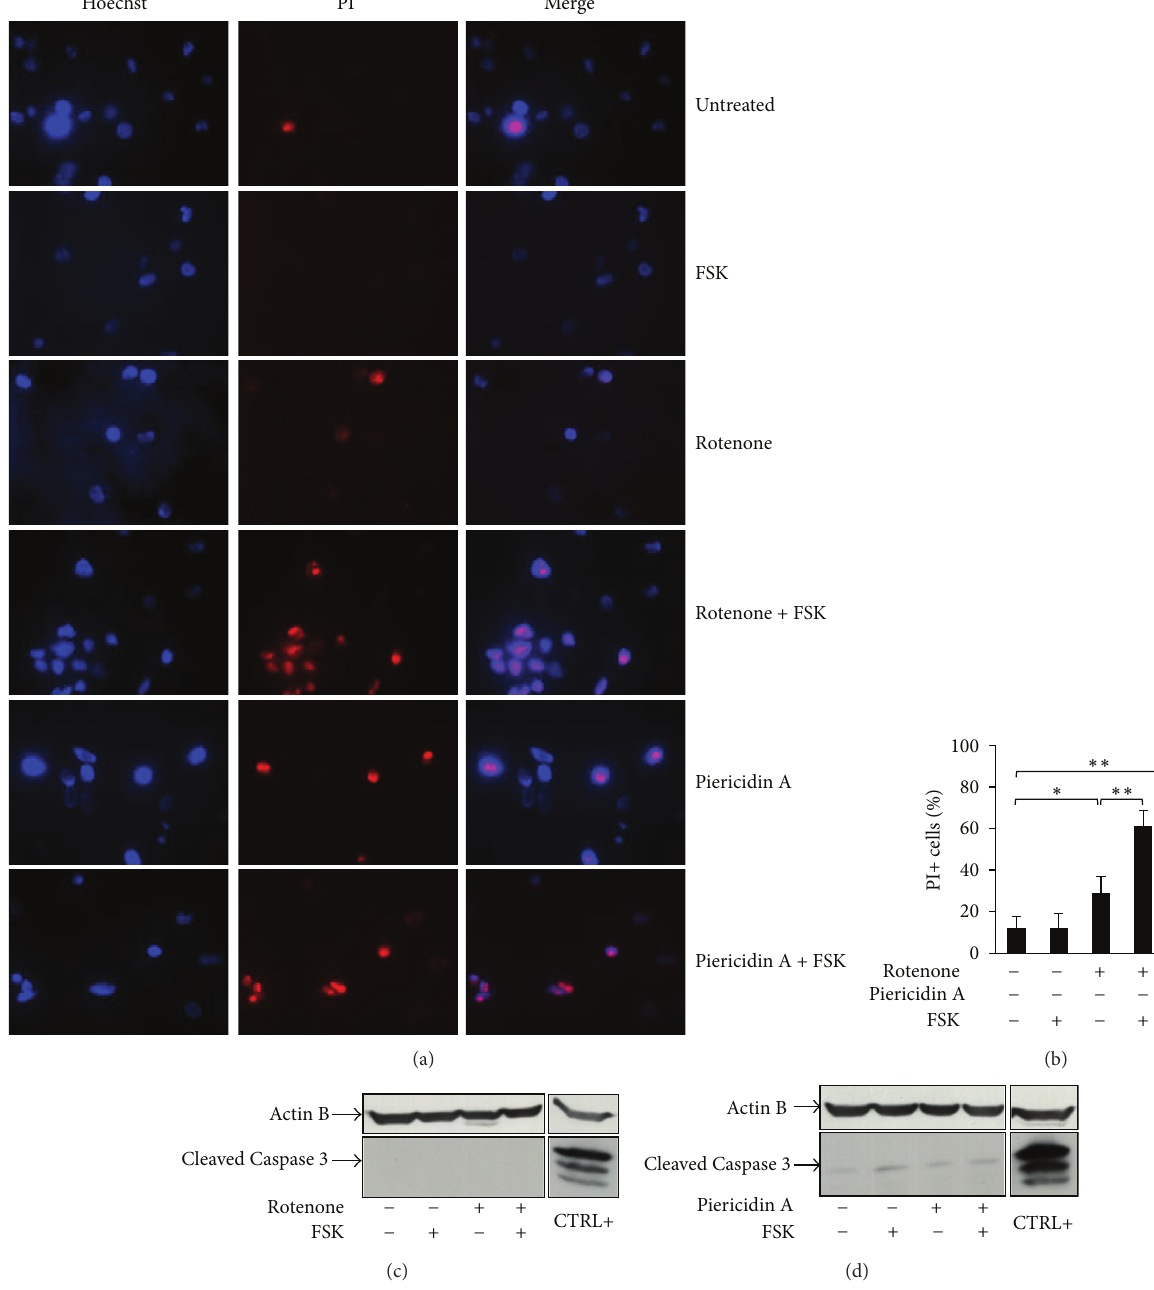
Figure 5: The combined treatment with Complex I inhibitors and FSK induces necrosis of MDA-MB-231 cells. Analysis of cell death was performed for MDA-MB-231 cells grown in low glucose and treated with 3nM rotenone and 5 nM piericidin A alone or in combination with FSK. (a)-(b) Cells were stained with Hoechst and PI (a). As indication of necrosis cells that incorporated PI were counted and shown as percentage of the total cells (stained with Hoechst) considering at least 100 cells per sample (b). Data represent the average of at least three independent experiments ( ± s.d.); ∗ 𝑃 < 0.05 , ∗∗ 𝑃 < 0.01 (Student’s 𝑡 -test). (c)-(d) As indication of apoptosis the expression of the cleaved Caspase 3 was analyzed in cells treated with (c) rotenone and (d) piericidin A. As apoptotic control MDA-MB-231 cells were treated with thapsigargin (CTRL+). As loading control the expression of Actin B was evaluated. Data are representative of three independent